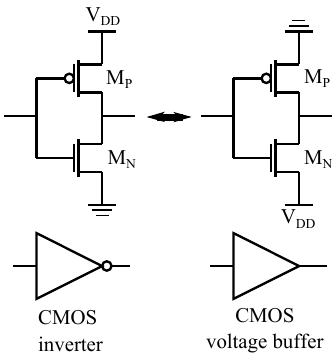
Figure 5. Representation of the symmetry between CMOS inverter and CMOS voltage buffer.